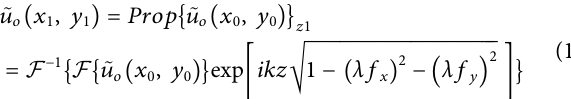
Frontiers in Physics |